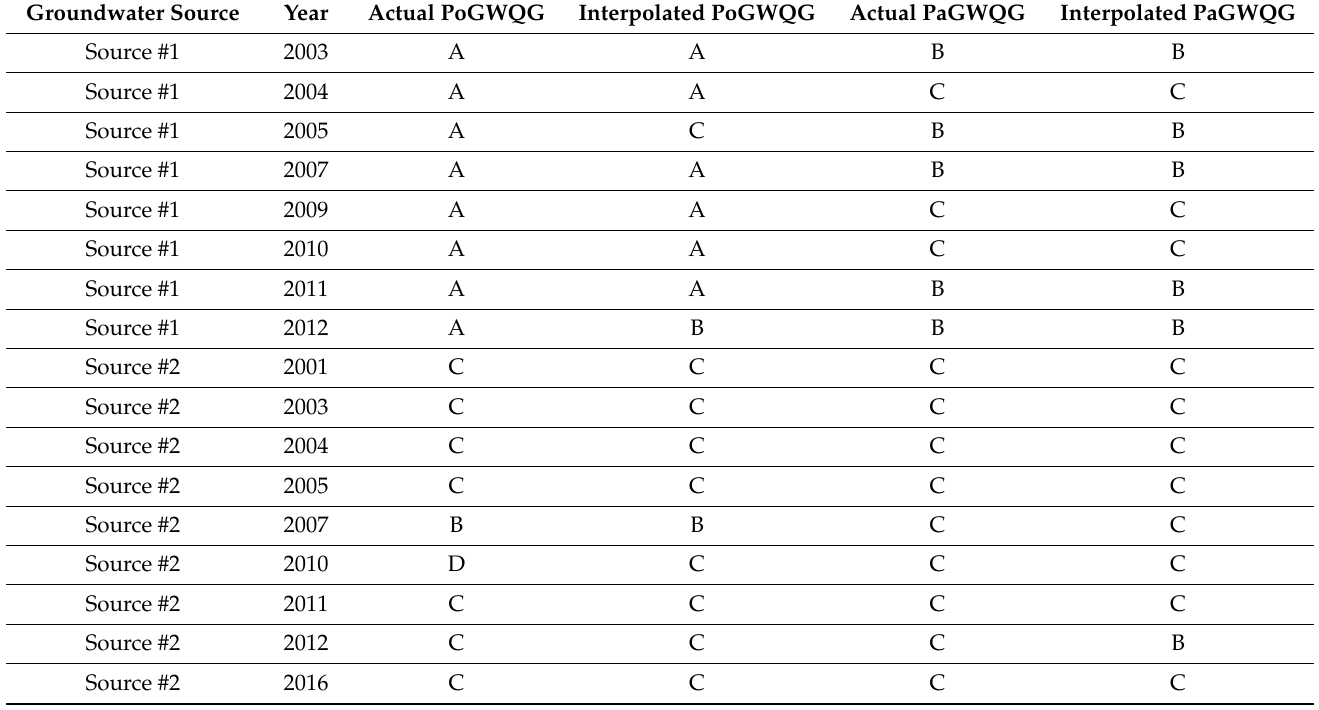
Table 5. Cross-validation results for PoGWQGs and PaGWQGs among two groundwater wells in the West Bank. Groundwater